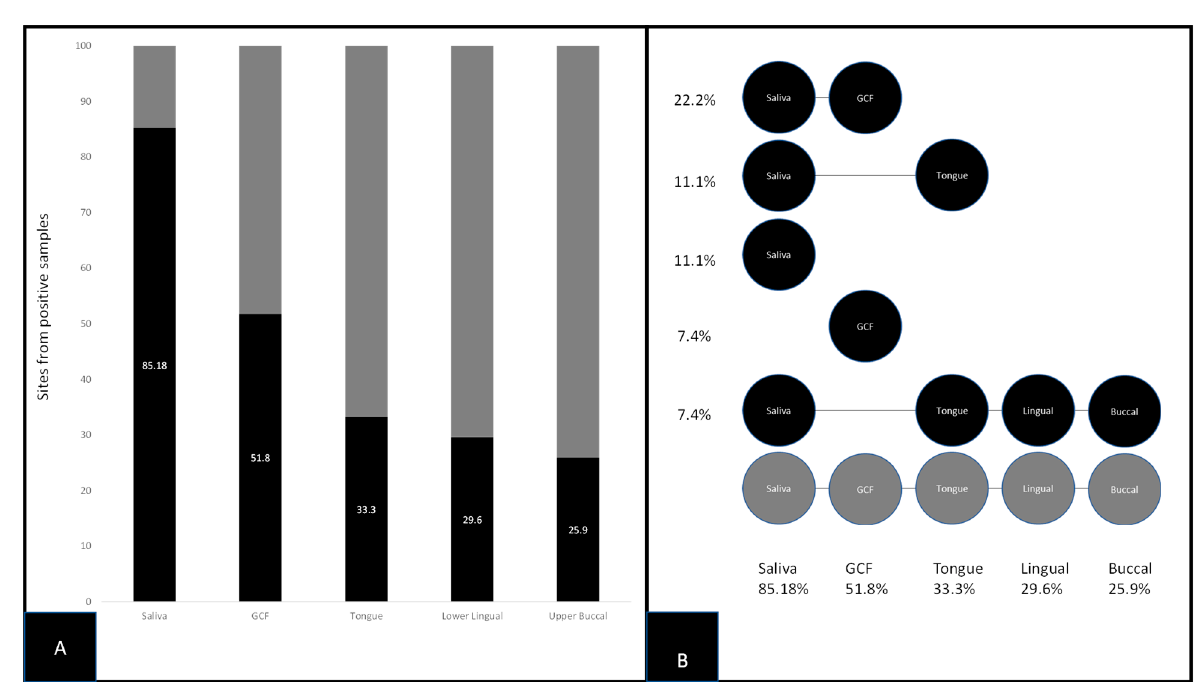
Figure 3. qPCR screening of samples for S. noxia . ( A ) Molecular screening revealed a total of n = 62/235 sites or 26.3% harboring SN with saliva and GCF (either alone or in combination with one or more sites) most often observed; Saliva, n = 23/27 or 85.18%, GCF, n = 14/27 or 51.%. ( B ) Analysis of site-specific data revealed most positive results were found among saliva and GCF alone or in combination, with fewer positive results observed among the tongue (33.3%), lower lingual incisor (29.6%), and upper buccal molar 25.9%.